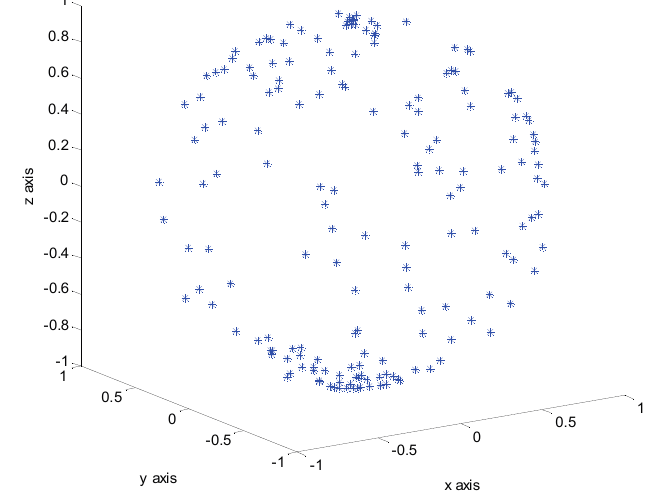
Figure 2. Normalized positions of Reference stars in the Celestial